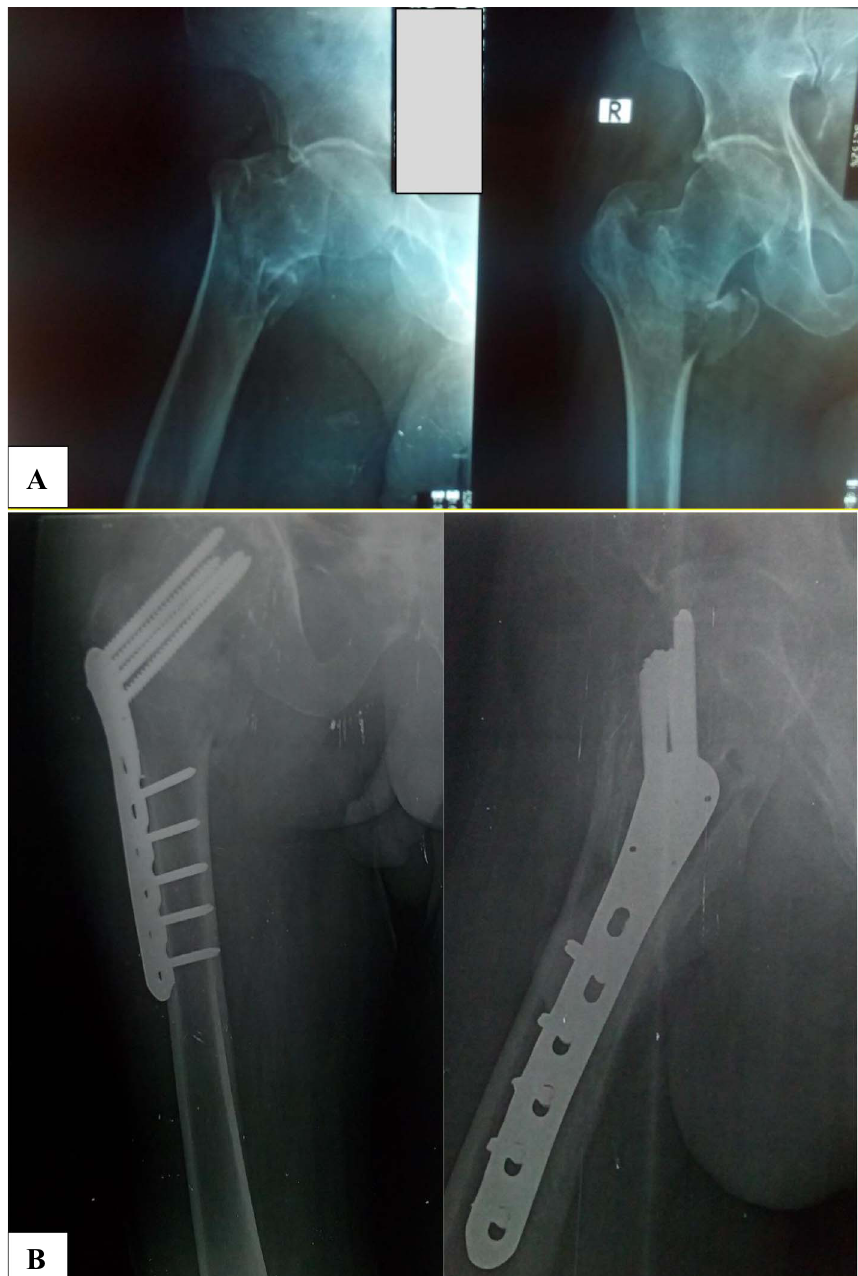
Figure 2. X-rays of 62-year-old male patient with AO 31A2.2 pertrochanteric fracture managed by PFLP; (A) Pre-operative X-rays; (B) X-rays at 6 months